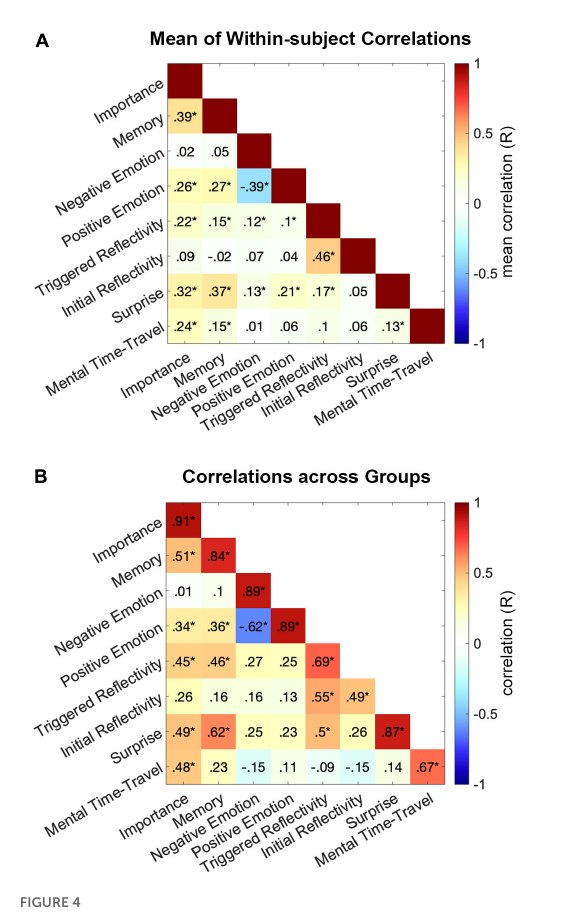
FIGURE4 Collinearities among cognitive measures. Correlations were calculated between each pair of cognitive measures across all 55 events. (A) Presents the mean across subjects of correlations calculated for each individual participant. Significance for each pair of measures was assessed in a t -test of the Fisher-transformed correlation coefficients, across subjects, against zero. (B) Presents the symmetrized matrix of correlations between the two groups. Significance for each pair was tested on its mean correlation coefficient. *FDR corrected P < 0.05.